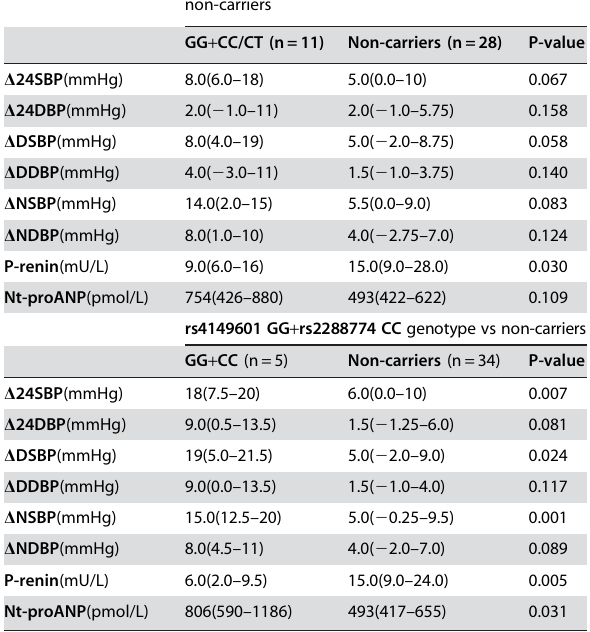
Table 3. Salt-induced changes in blood pressure, and baseline P-renin and Nt-proANP in different genotype carriers. .. ... .... ... ... .... ... ... .... ... ... .... ... ... .... ... ... .... ... ... .... . rs4149601 GG + rs2288774 CC/CT genotype variants vs